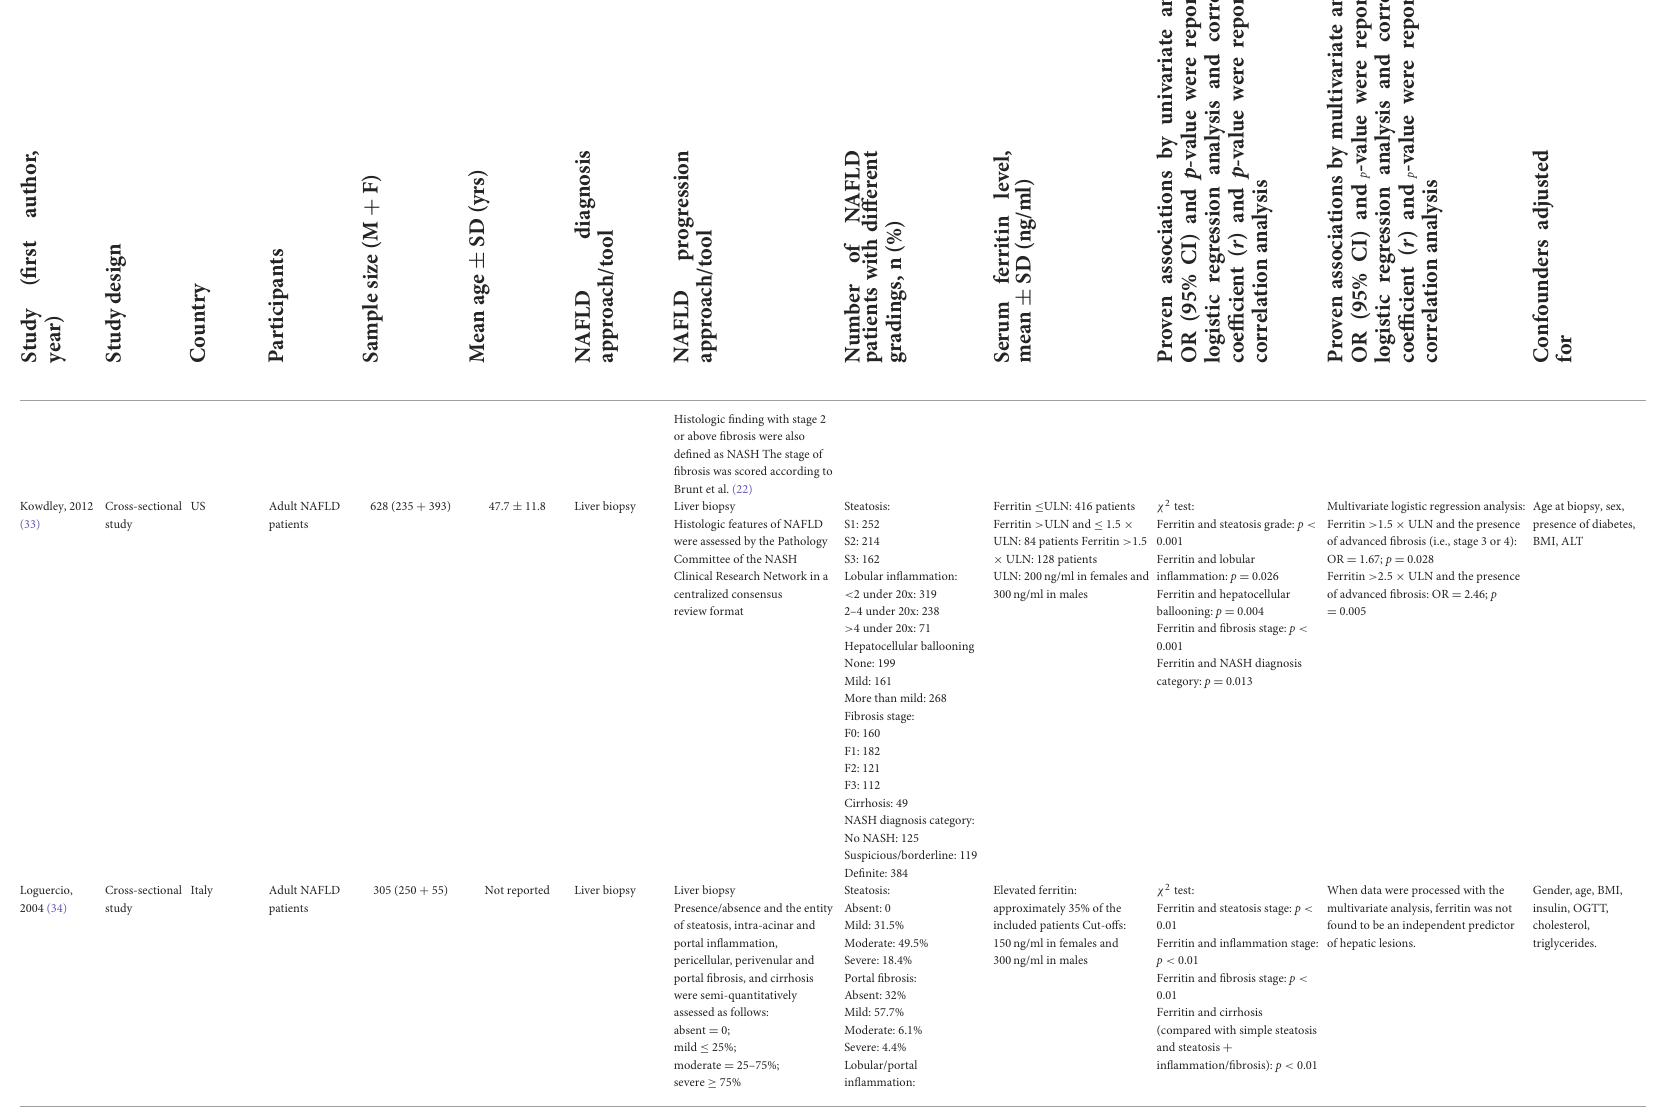
ballooning: p = 0.004 Ferritinandfibrosisstage: p < 0.001 FerritinandNASHdiagnosis category: p = 0.013